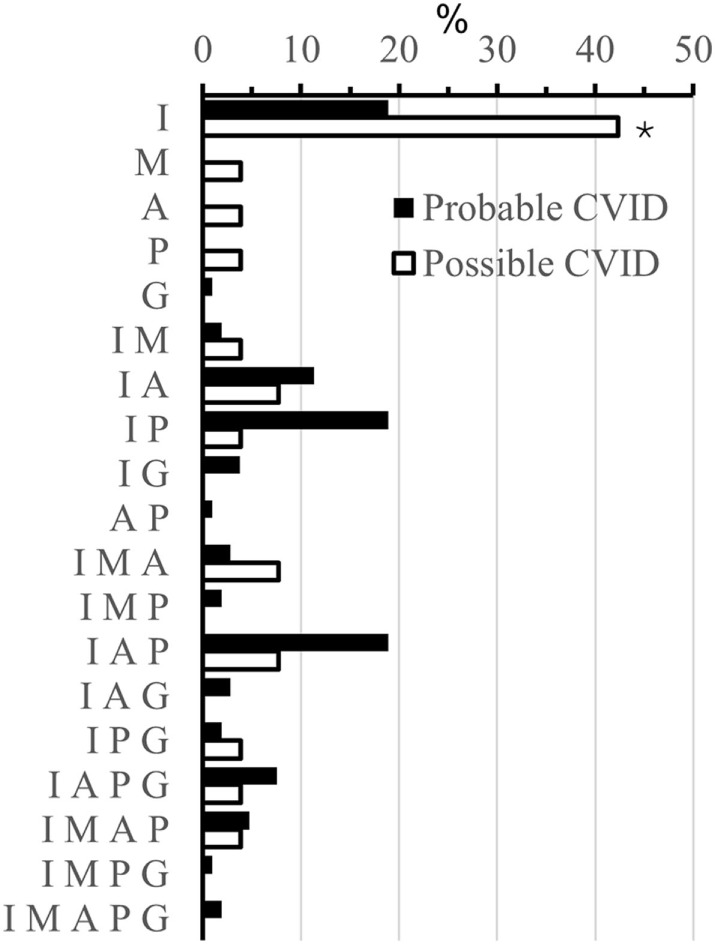
Different phenotypes (%) in probable and possible CVID. Phenotypes are abbreviated as follows; also their combinations are used: I, infections; M, malignancies; A, autoimmunity; P, polyclonal lymphocytic proliferation; G, gastrointestinal disease. Asterisks mark statistical significance between “probable” and “possible CVID” patients, *p < 0.05 (Fisher’s 2-sided Exact test).